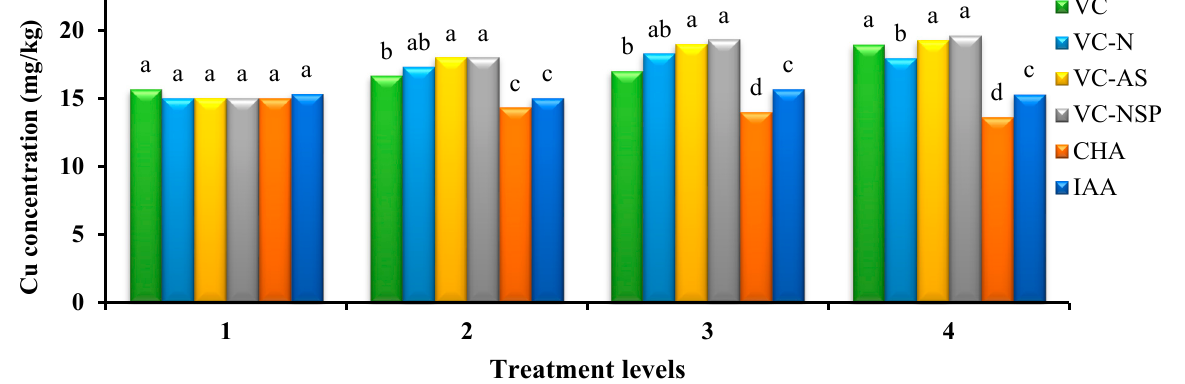
Figure 8. Comparison of average soil application of experimental treatments on P-concentration at treatment levels (levels 1, 2, 3 and 4 for VC, VC-N, VC-AS and VC-NSP treatments of 0, 1, 2 and 3% VC, 0, 200, 400 and 600 mg of CHA per kg of soil and 0, 10 − 6 , 10 − 5 and 10 − 4 molar IAA). Different letters in each figure show significant difference at p ≤ 0.05 by Duncan multiple range test. VC, VC without enrichment; VC-N, VC enriched with 1% nitrogen; VC-NSP, VC enriched with 1% nitrogen, 1% sulfur, and 1% phosphorus; VC-AS, VC enriched with Azotobacter chroococcum (21Az) + Pseudomonas fluorescens (Ps 59); CHA, Commercial humic acid; IAA, Indole-3-acetic